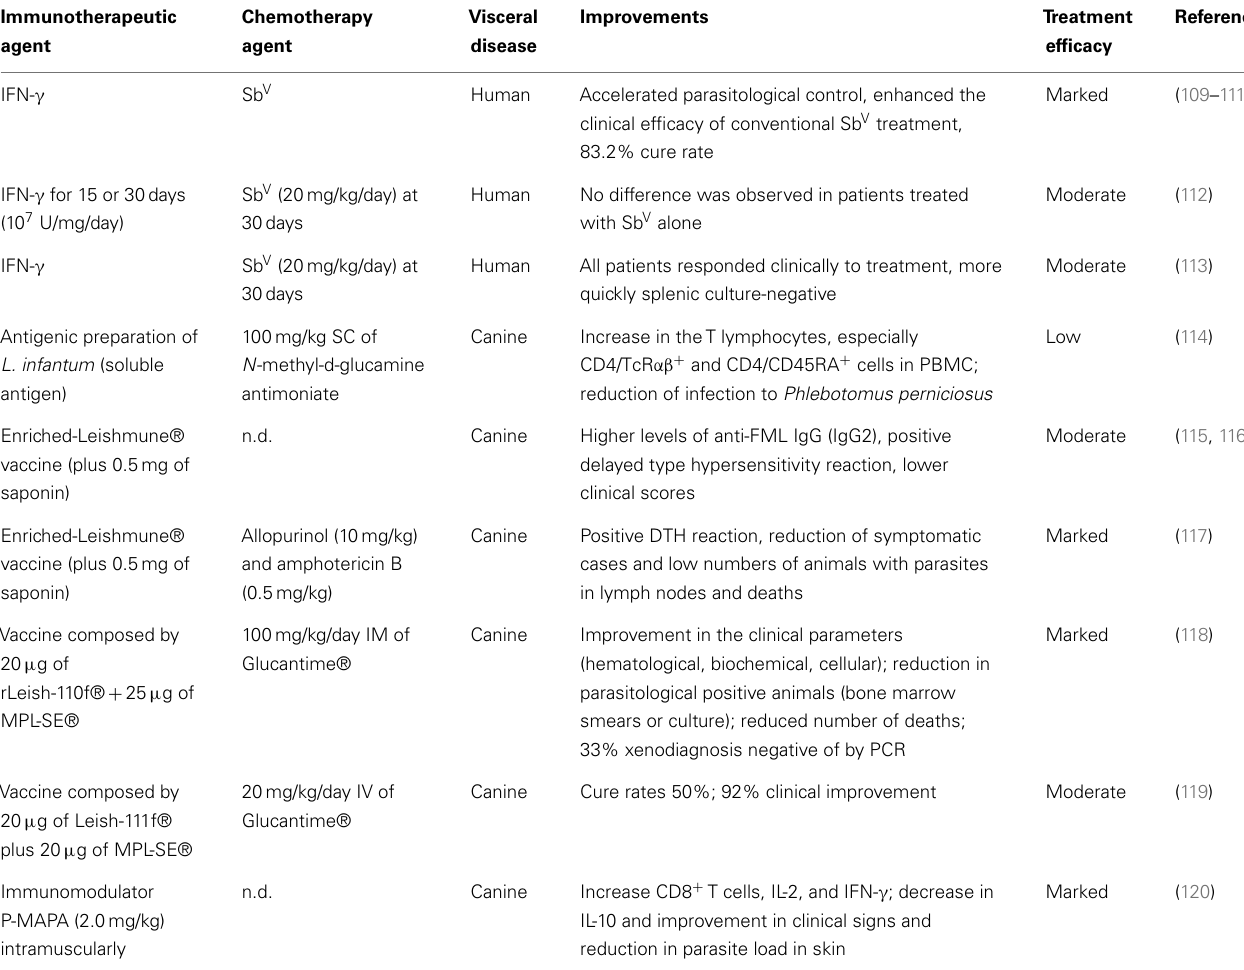
Table 3 | Immunotherapy and immunochemotherapy strategies againstVL for humans and dogs .